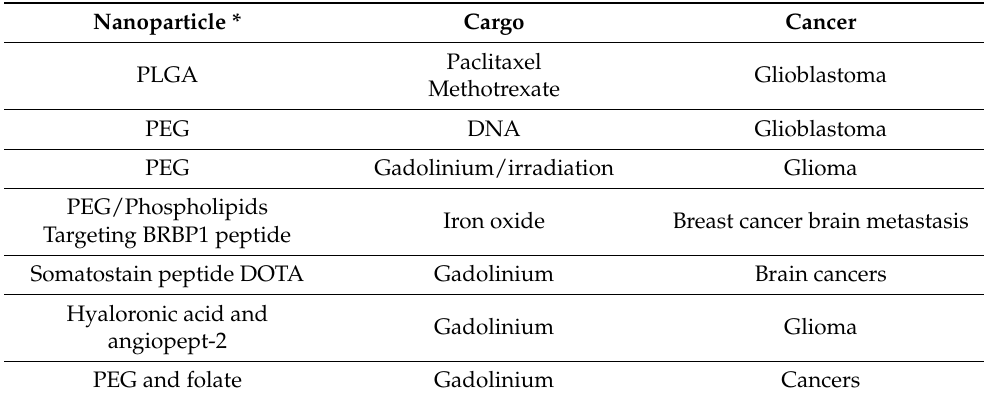
Table 1. Therapeutic delivery of brain-targeted therapeutic/theranostic modalities [156–162].